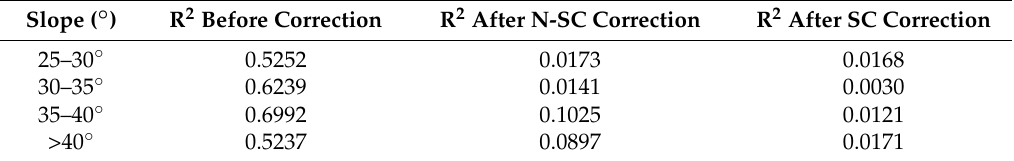
Table 2. The coefficient of determination values (R 2 ) between reflectance and illumination before and after the topographic correction for the red band and slopes greater than 25 ◦ . Image: Landsat TM from 2 December